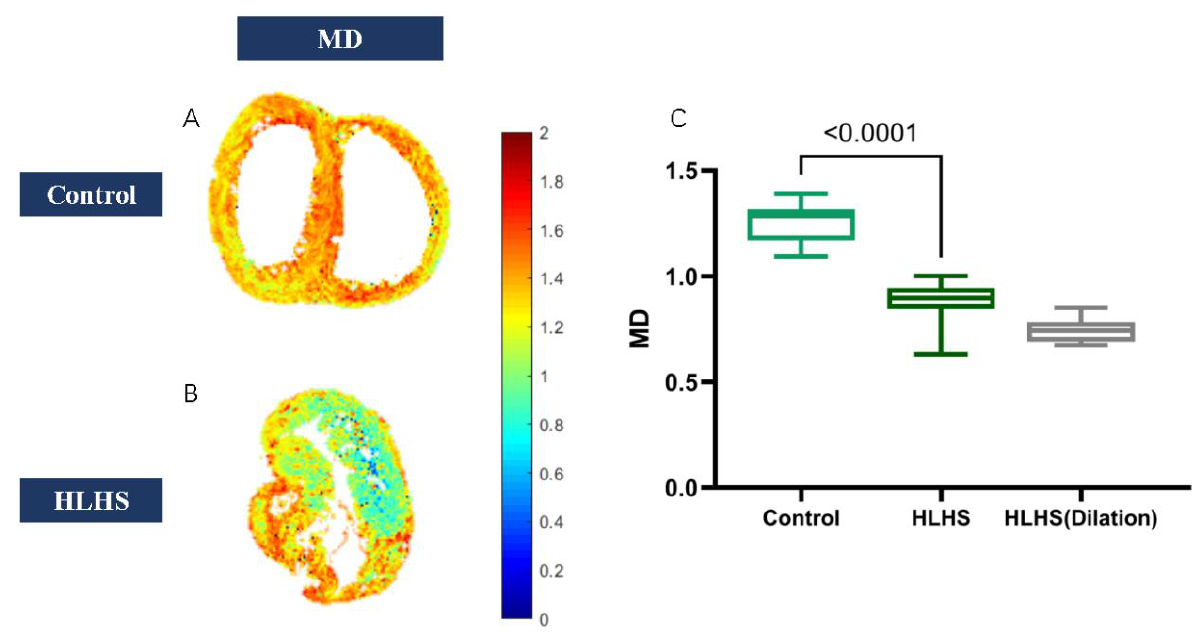
Figure 2. ( A ) FA map in normal fetuses. ( B ) FA map in HLHS fetuses. ( C ) FA values increased in HLHS fetuses.